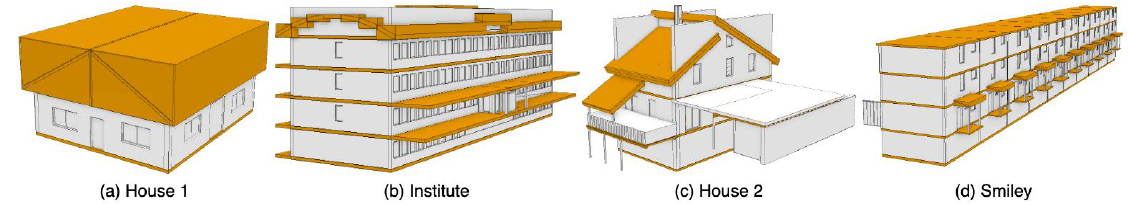
Figure 19. Models generated by DIA/FME.